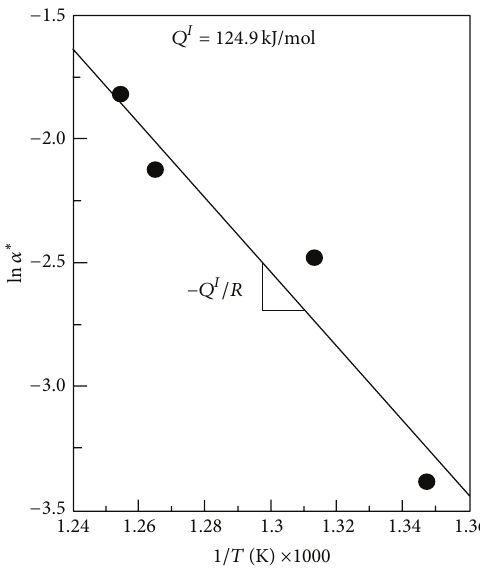
Figure 9: The plot of ln ̇𝛼 ∗ versus 1/𝑇 provides a means of deter- mining the activation energy 𝑄 𝐼 .